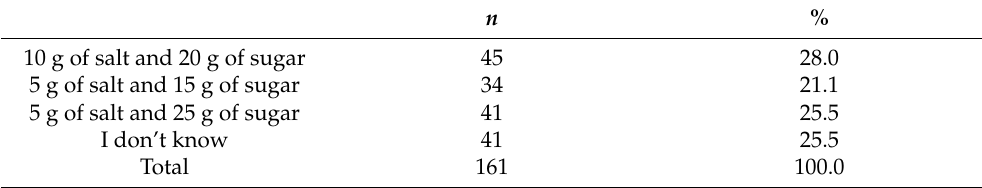
Table 2. Knowledge about the daily consumption of salt and sugar recommended by the WHO.